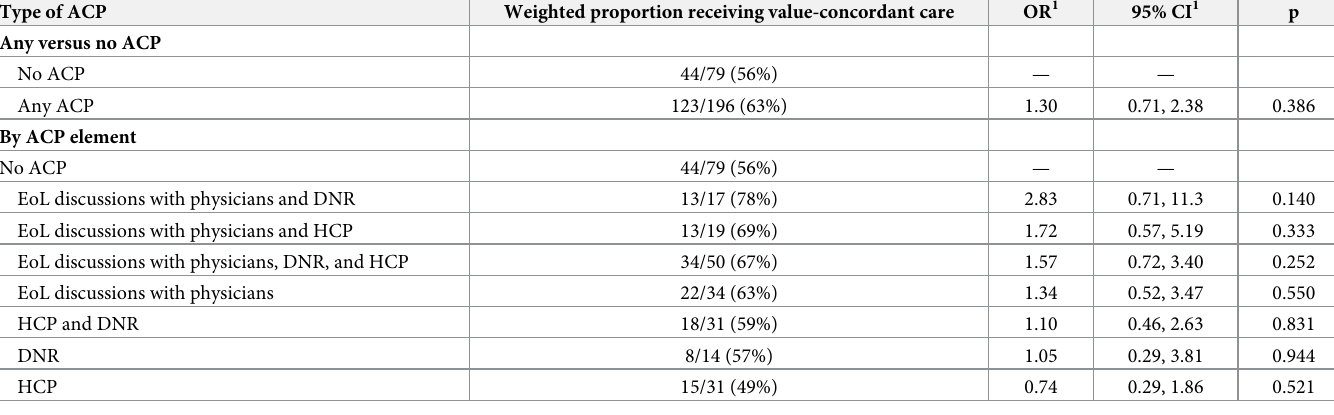
Table 4. Odds of receiving value-concordant care by type of ACP using hospice for at least one week as sole indicator of value-concordant care (N = 275).